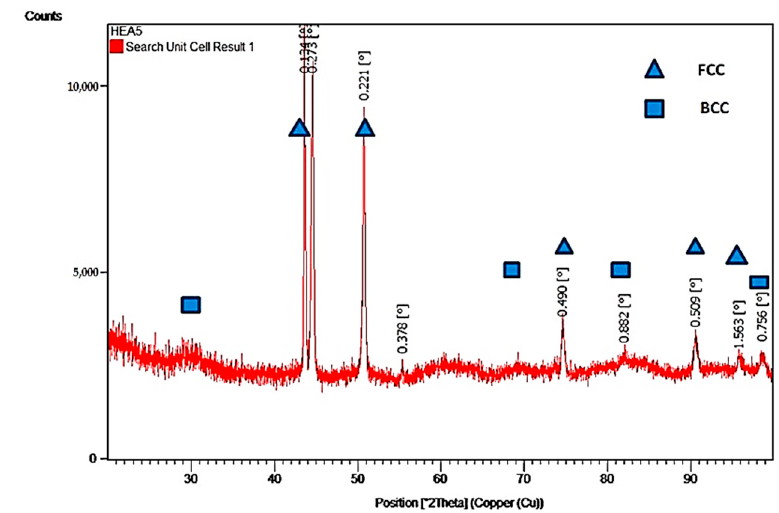
Figure 3. XRD diagram for Al 0.8 CrFeCoNi high-entropy alloy.